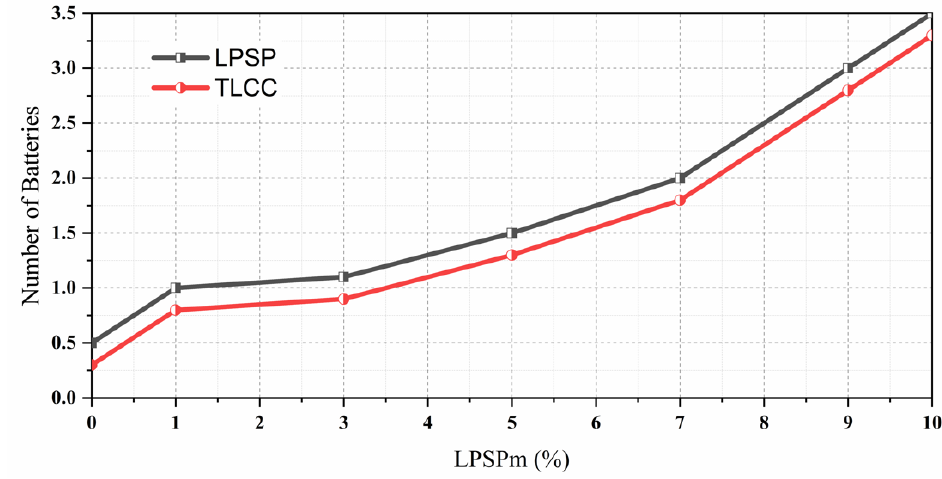
Figure 6. Various loss of power supply probability for the system configurations.